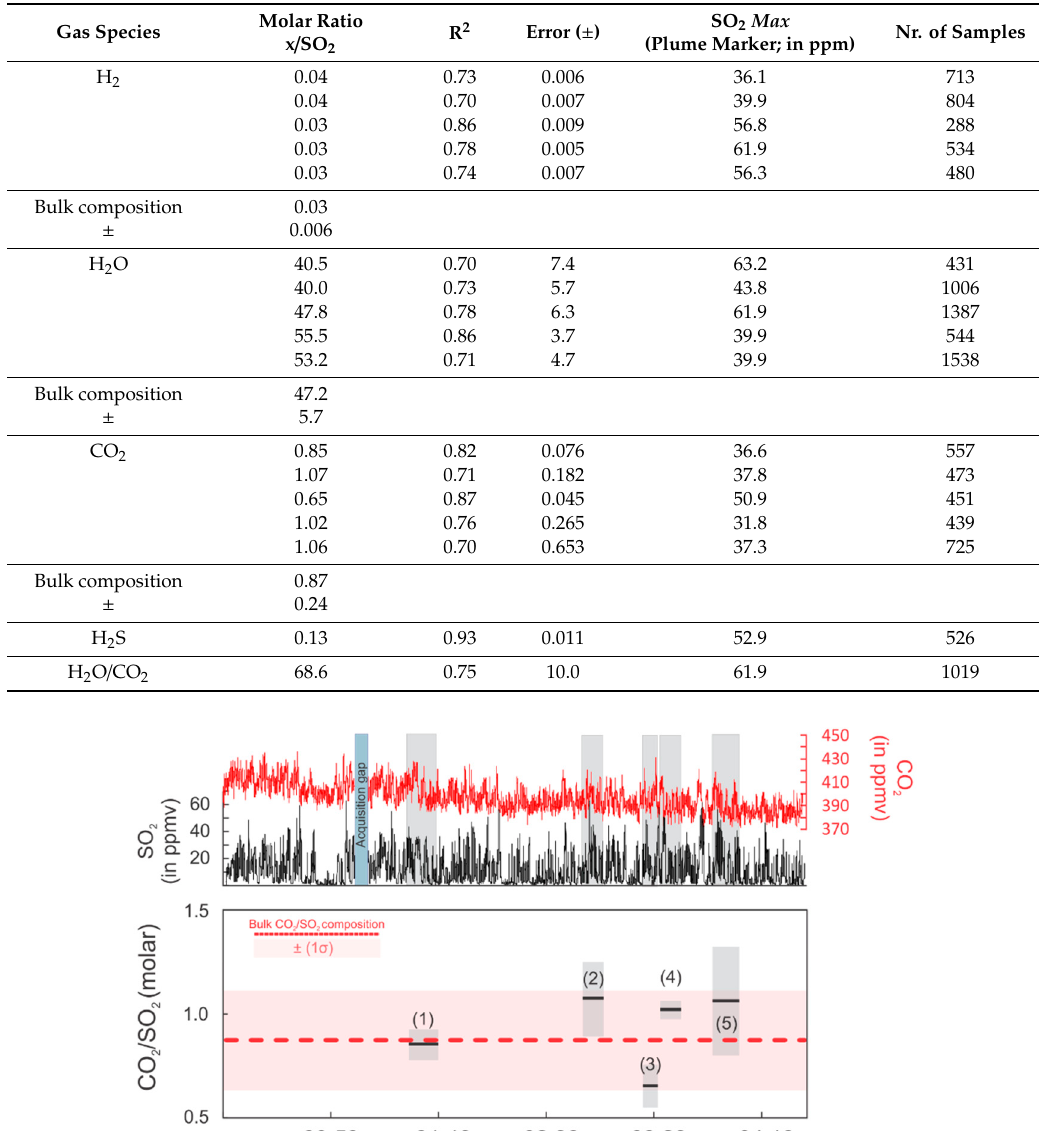
Table 1. Individual x/SO 2 molar ratios measured by the multi-component gas analyzer system (multi- GAS) in the Mount Garet’s plume. These correspond to time windows showing good temporal correlation between gas species (R 2 ≥ 0.70) and strong volcanic gas signal ( ≥ 30 ppm of SO 2 ). Ratios and associated errors correspond to the slope and the R 2 value of the best-fit regression line, respectively.